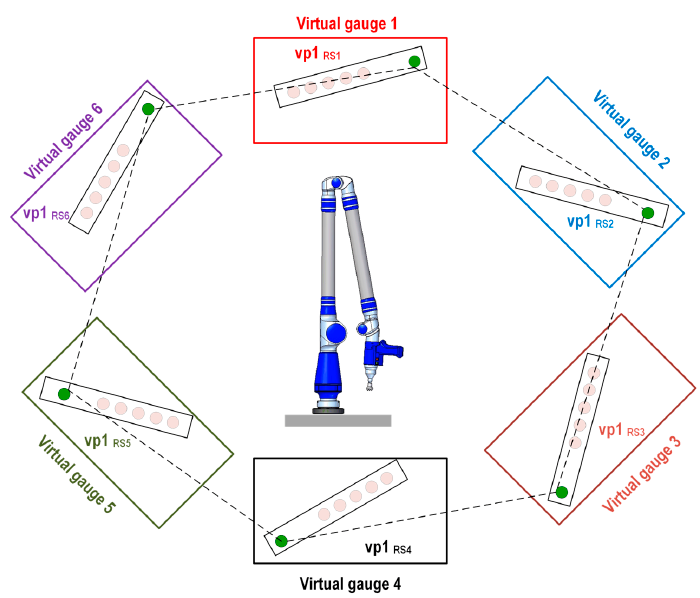
Figure 7. Evaluation method 2: virtual distance between virtual point in gauge 1 and their equivalent virtual points in consecutive gauges.